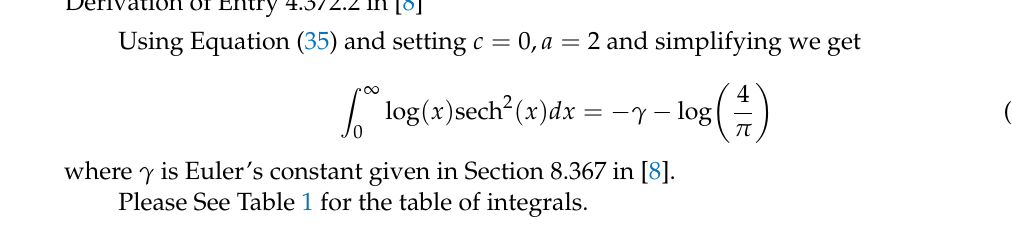
Table 1. Table of